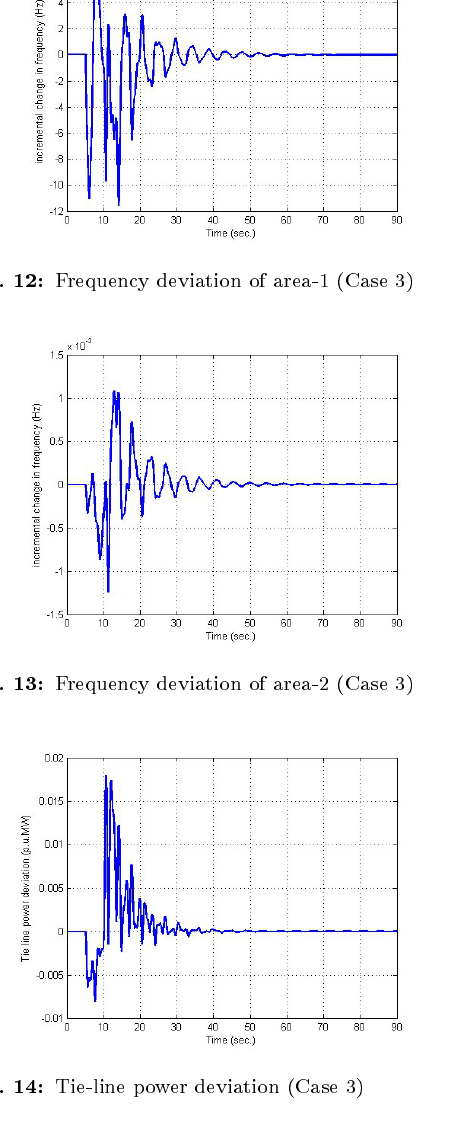
system is still stable and that the steady-state values of frequency deviation and tie-line power deviation still converge to zero.